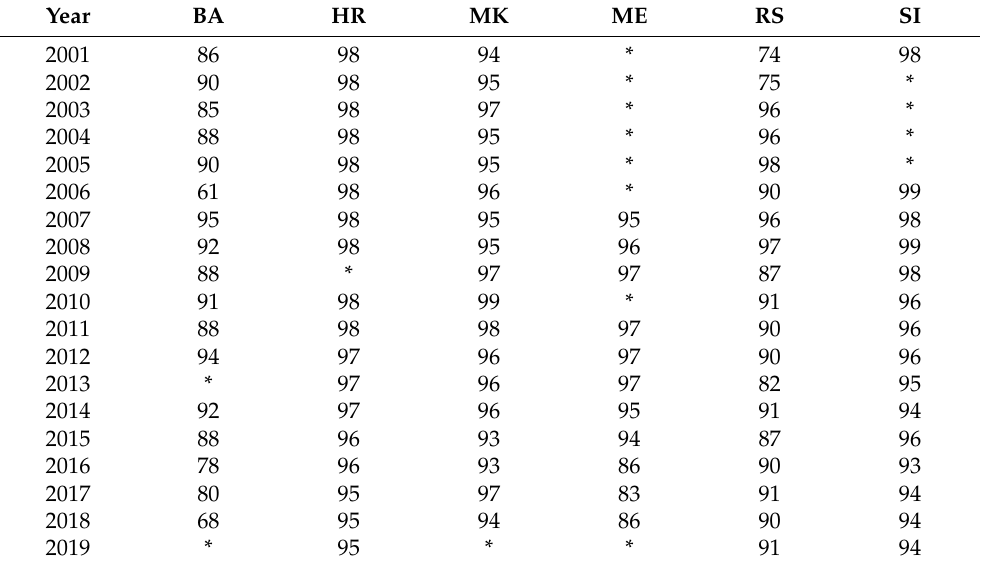
Table 4. Measles-containing revaccination (%) in Croatia and neighboring countries in the years 2001 to